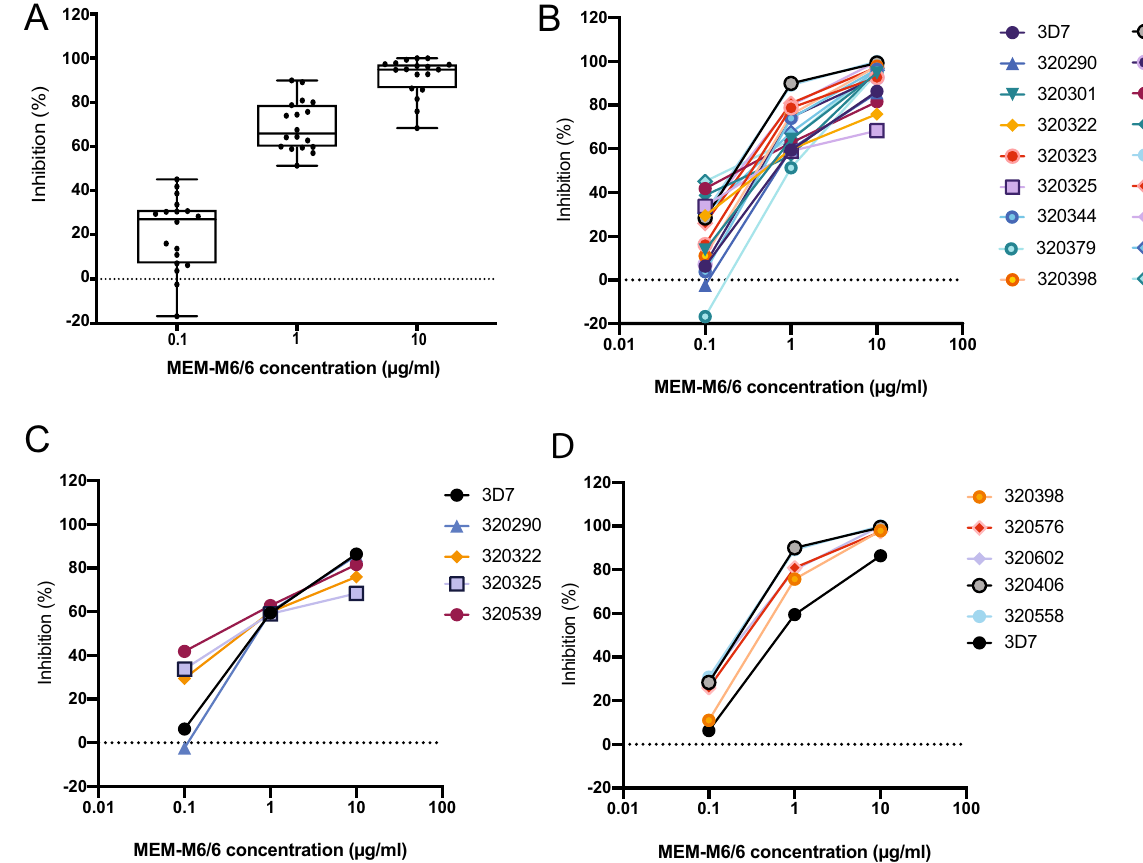
Figure 1. Monoclonal antibodies targeting BSG potently inhibit ex vivo Plasmodium falciparum isolates in a dose-dependent manner. The data from the 17 successful ex vivo invasion assays are shown here. PMR is calculated as: Final parasitemia (RPMI alone)/Initial parasitemia (RPMI alone). Invasion inhibition was calculated as 100- [(Average Percent invasion in anti-BSG MEM-M6/6 antibody wells)/(Average parasitemia in IgG1 isotype control wells) * 100]. Parasitemia was counted using a Miller reticle and 500 erythrocytes were counted for each assay. ( A ) Distribution of inhibition at each concentration: 0.1 µ g/ml, 1 µ g/ml, and 10 µ g/ml, demonstrating overall conservation in inhibition at each concentration. Box and whisker plots show the median, interquartile range, and whiskers indicate the minimum and maximum. ( B ) Dose-response curves for inhibition with anti-BSG MEM-M6/6 antibody for each sample, including 3D7 for reference. ( C ) Dose-response curves for inhibition with anti-BSG MEM-M6/6 antibody for samples from the bottom 25% of inhibition (calculated from the 10 µ g/mL concentration), including 3D7 for reference. ( D ) Dose-response curves for inhibition with anti-BSG MEM-M6/6 antibody for samples from the top 25% of inhibition (calculated from the 10 µ g/mL concentration), including 3D7 for